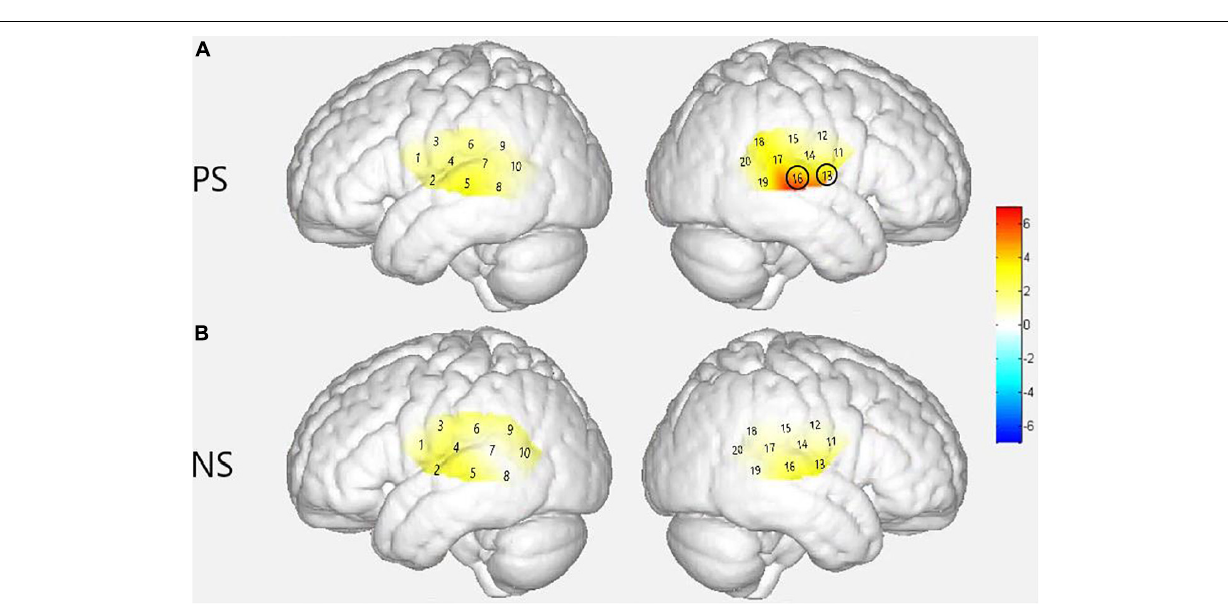
Frontiers in Neuroscience |